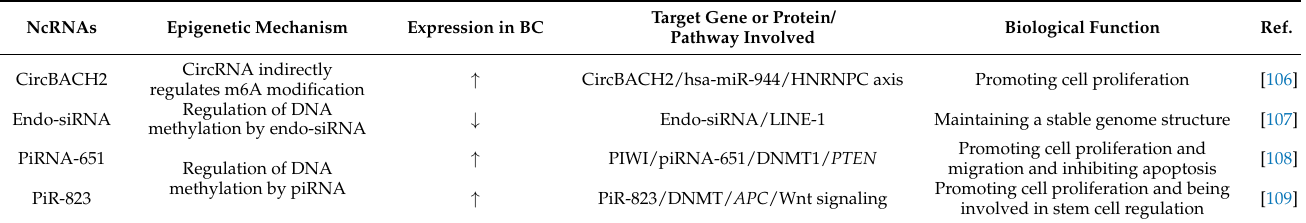
Table 3. Crosstalk between different methylation types and other ncRNAs in